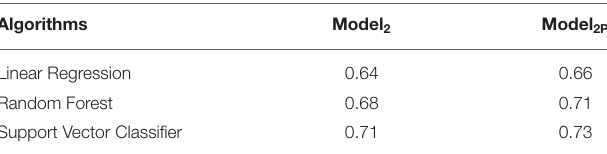
TABLE 1 | Comparison of the performances of Model 2 and Model 2P in predicting the severity of abnormality of lung